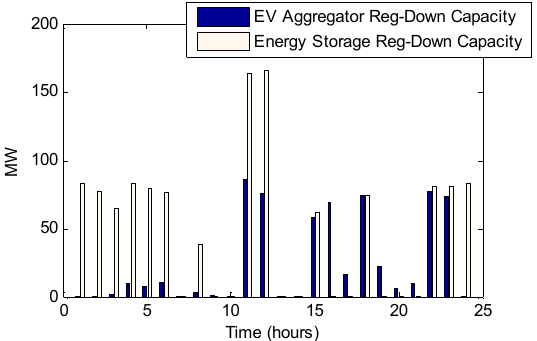
Figure 7. POP for the Electric Vehicle (EV) aggregator and dedicated storage unit.